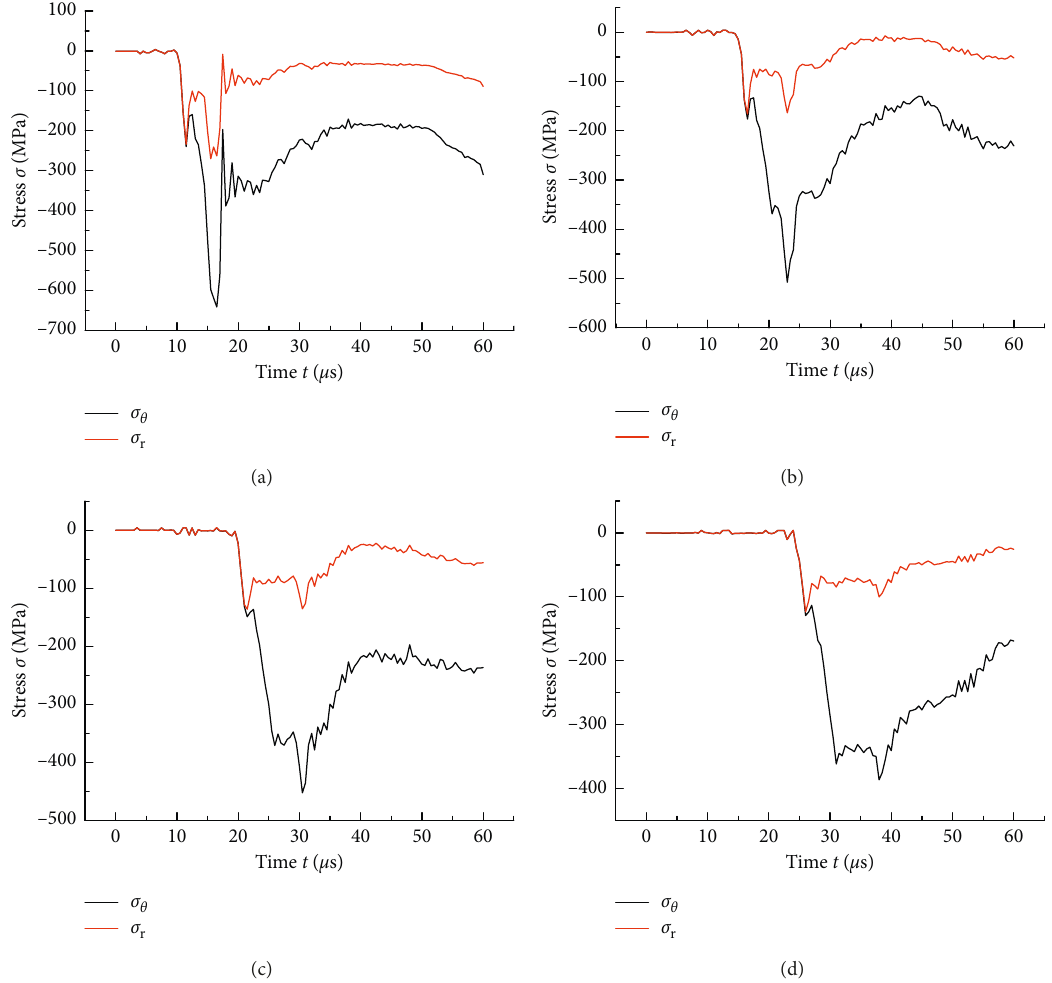
Figure 7: Contrast of radial stress and tangential stress on adjacent empty hole wall. (a) a /2 r (d) a /2 r 1 � 12.5.